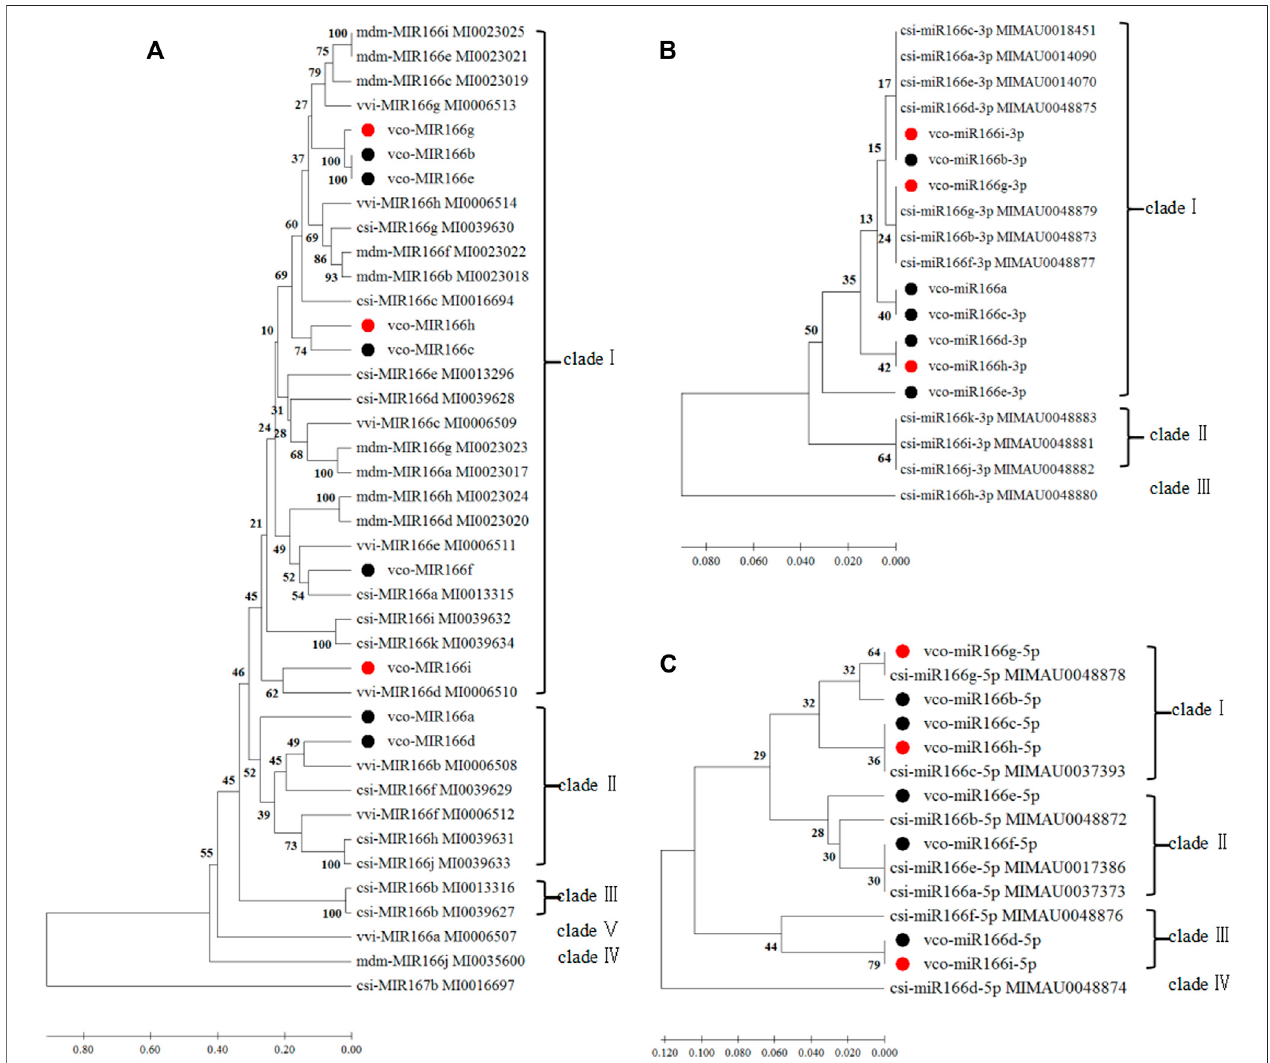
FIGURE 2 | Phylogenetic analyses of miR166 loci and their predicted 3 ′ and 5 ′ arms. Sequences were aligned in MEGA X, and the phylogenetic tree was constructedwiththeUPGMAmethod (A) PhylogeneticanalysisofVco-miR166precursorsandrelated sequencesfromCsi, Citrussinensis ;Vvi, Vitisvinifera ;andMdm, Malus domestica . Csi-MIR167 b served as the outgroup (B,C) Phylogenetic analysis of mature Vco-miR166s and Csi-miR166s for the 3 ′ arm (B) and 5 ′ arm (C) . Black and red dots indicate mature miR166sor their precursors ofhighbushblueberry from aprevious study (Hou et al., 2017) and thisstudy, respectively. The numbers at the nodes indicate the percentage of support from 1,000 bootstrap replicates. The scale indicates the average number of amino acid substitutions per site.